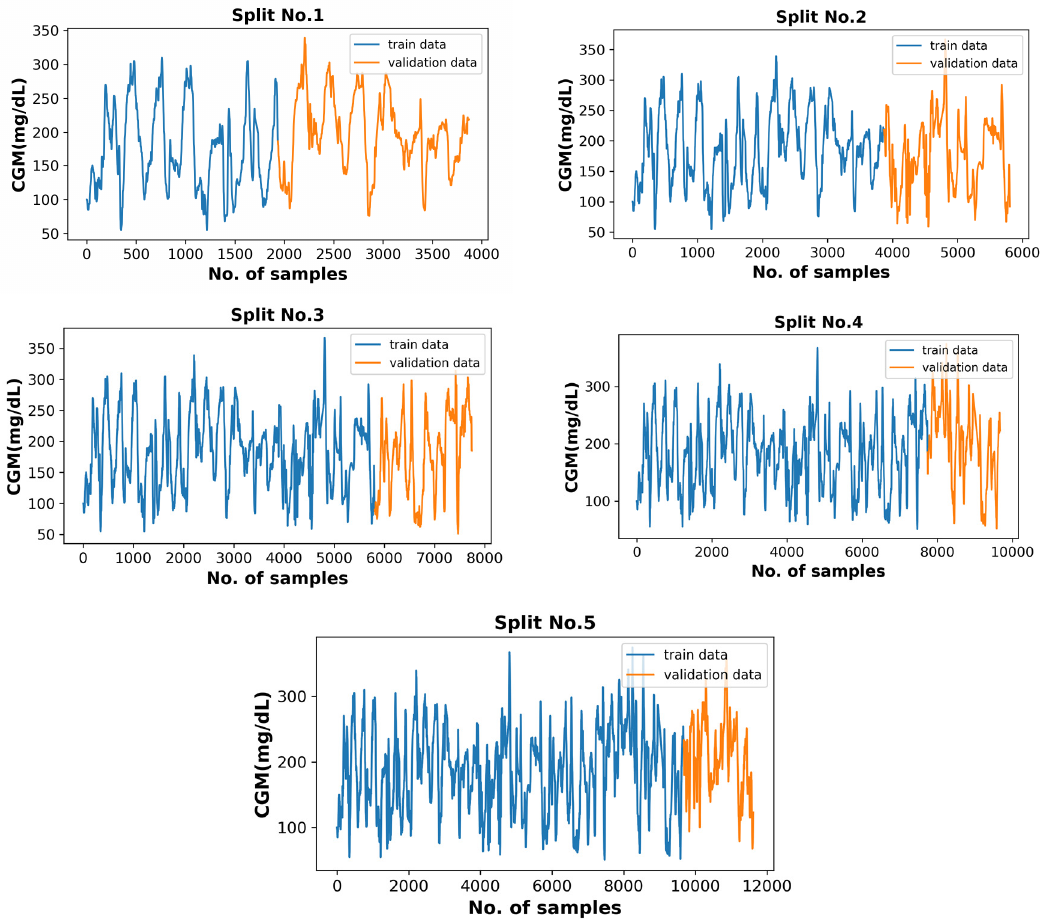
Figure 13. The five combinations of training–validation splits for CGM data of patient ID